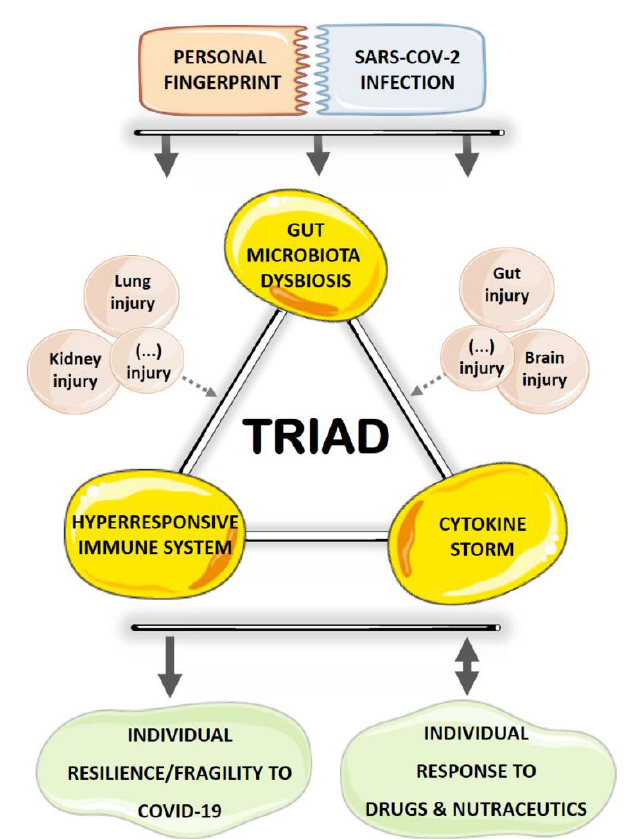
Figure 1. The interplay between the gut microbiota dysbiosis–immune hyperresponse–inflammation triad in Coronavirus Disease 2019 (COVID-19) and the putative influence on disease progression and response to therapies. Rather than being merely restricted to the lower respiratory tract, severe acute respiratory syndrome coronavirus 2 (SARS-COV-2) infection extends to other organs, namely the gastrointestinal tract (multi-tissue infection). Influenced by the lifetime cross-modulations between the immune system and the microbiota (like a personal fingerprint), gut microbiota dysbiosis, immune hyperresponse, and an inflammatory setting are elicited under these circumstances (triad). On behalf of the intricate influence of gut microbiota (GM) on host immune effectors and subsequent inflammatory profile, GM composition and function might contribute to explain the individual resilience/fragility to COVID-19 and/or the response to therapeutics, which deserves further research.